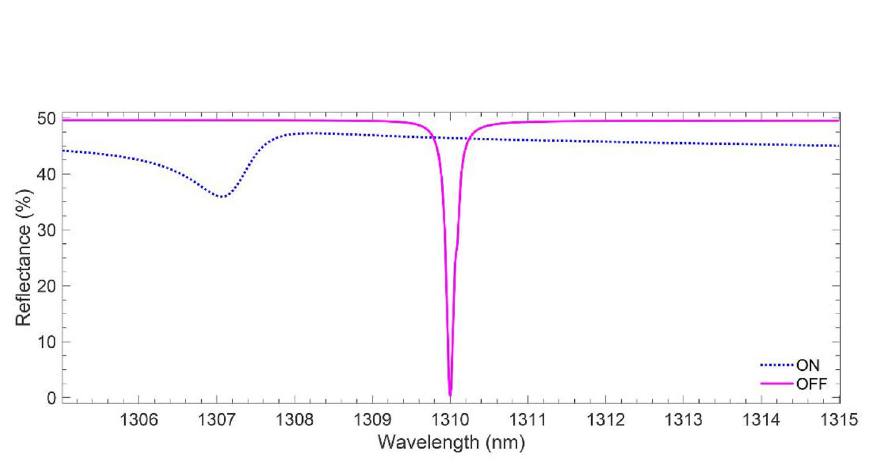
Figure 5. Reflectance spectra of the modulator for ON and OFF states at 1305 < λ <